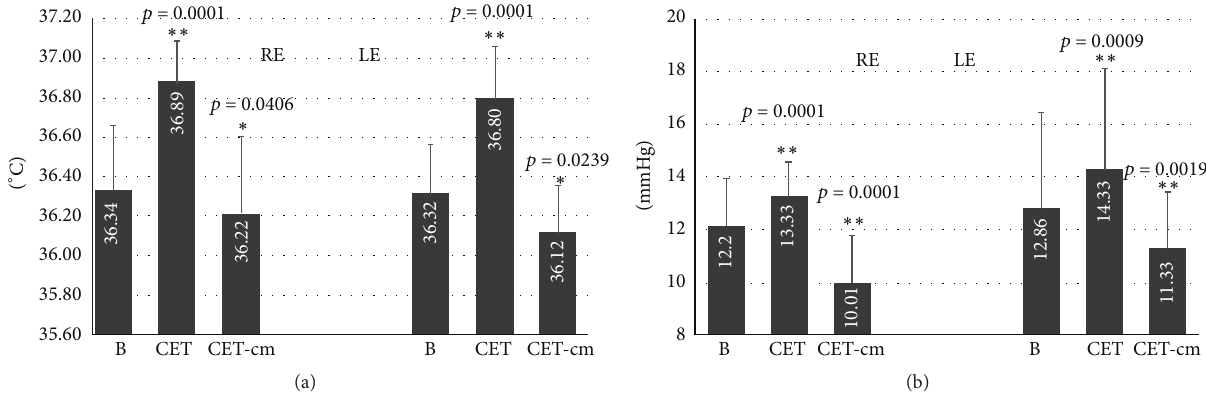
Figure 2: Variation of the average corneal temperature (a) and the IOP (b) in the right (RE) and left (LE) eye with open eyelids (b); after one hour with closed eyelids (CET) and after one hour with closed eyelids wearing a cooling mask (cm-CET). ∗ 𝑝 < 0.05 ; ∗∗ 𝑝 < 0.01 .